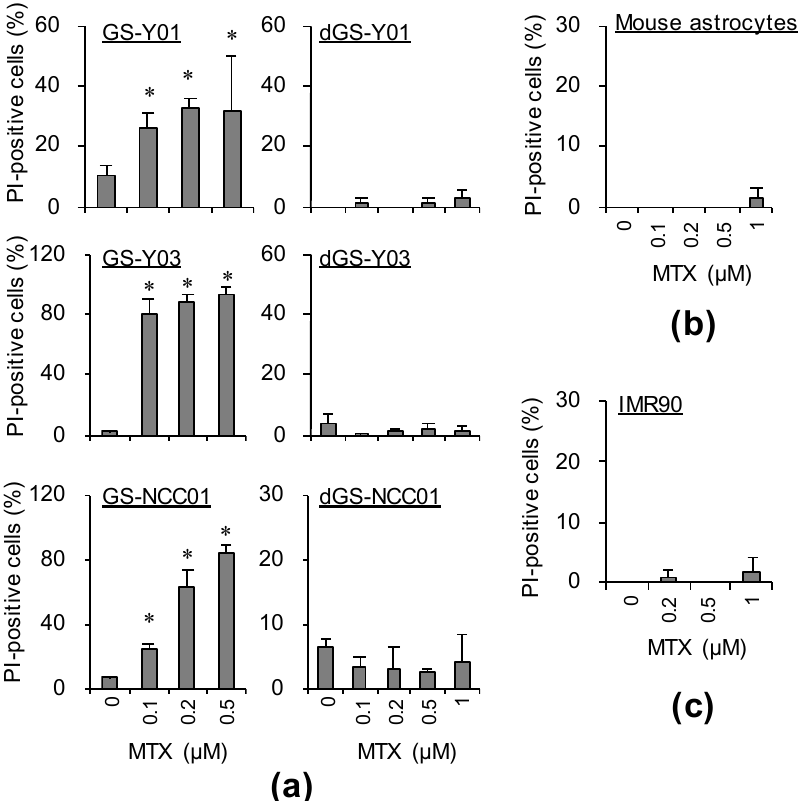
Figure 1. Methotrexate (MTX) induces cell death specifically in glioma stem cells (GSCs), but not in differentiated GSCs. GSCs (GS-Y01, GS-Y03, and GS-NCC01) and differentiated GSCs (dGS-Y01, dGS-Y03, and dGS-NCC01) ( a ), mouse astrocytes ( b ), and IMR90 cells ( c ) treated with the indicated concentrations of methotrexate (MTX) or control solvent treatment for 3 days were analyzed by propidium iodide incorporation assay. Similar results were obtained from two independent biological replicates. Data are presented as means + standard deviation. * p < 0.05 vs. control-treated cells by the Mann–Whitney U test.